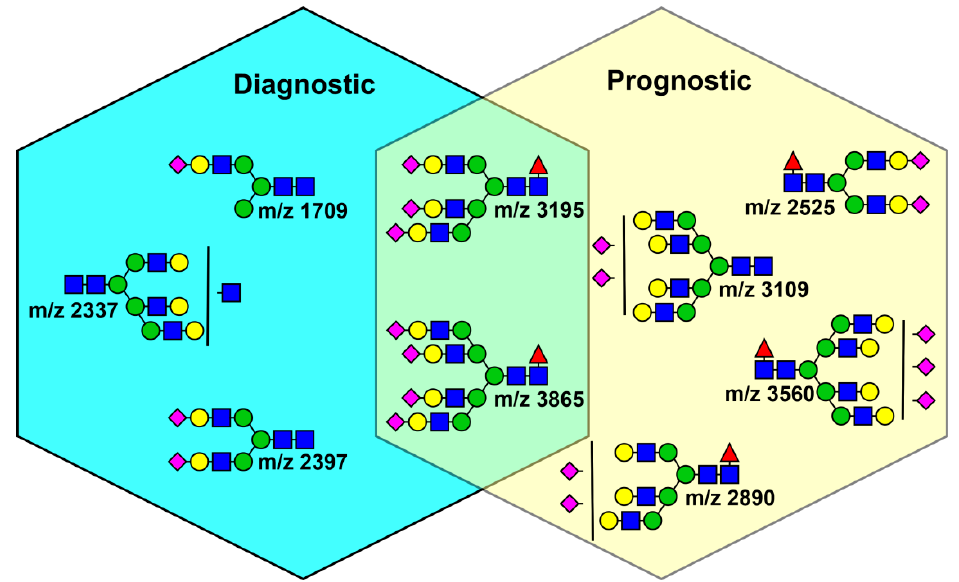
Figure 4. Representative diagrams of candidate N -glycans present in serum of GCT patients applicable as diagnostic or prognostic biomarkers. Terminal sialylated bi-antennary, tri-antennary and tetra-antennary complex-type N -glycans were selected as a GCT-related N -glycans. Reprinted from ref. [119] with modifications.